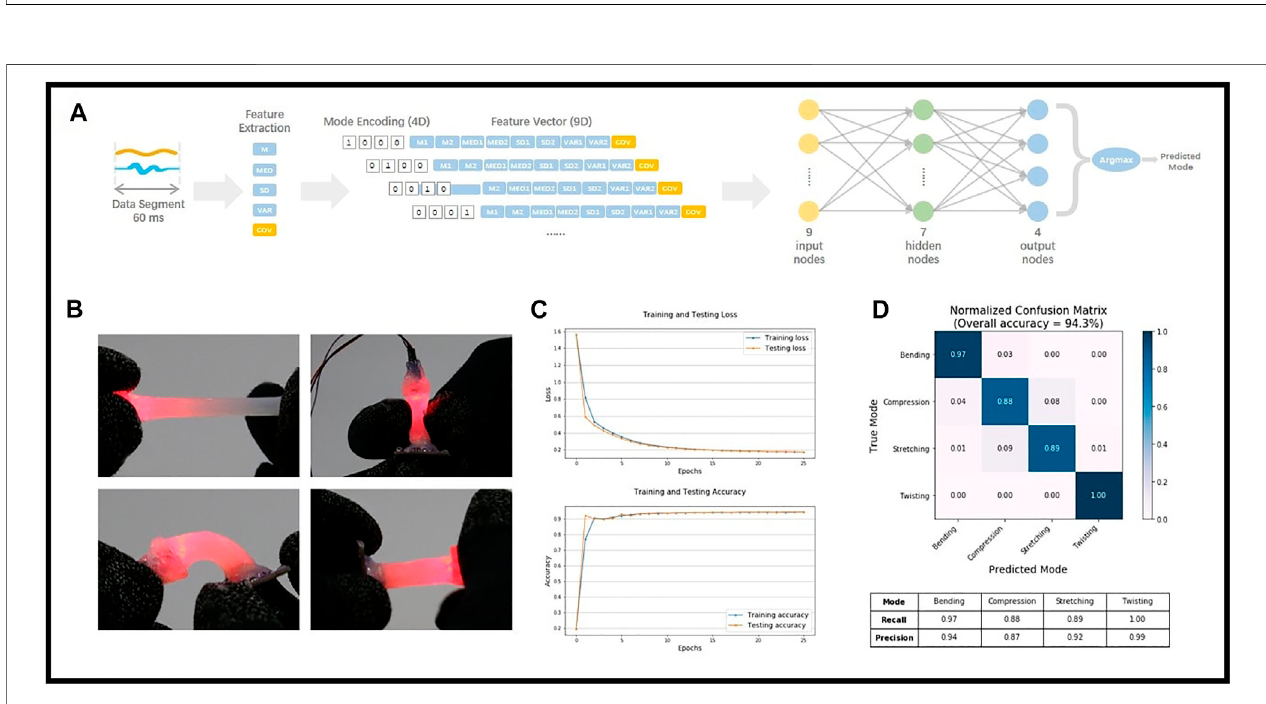
FIGURE 11 | Deformation mode classi fi cation. (A) The classi fi er establishment. (B) Four passive movements: bending, compression, stretching, and twisting. (C) Model loss and accuracy. (D) Classi fi cation performance evaluation.